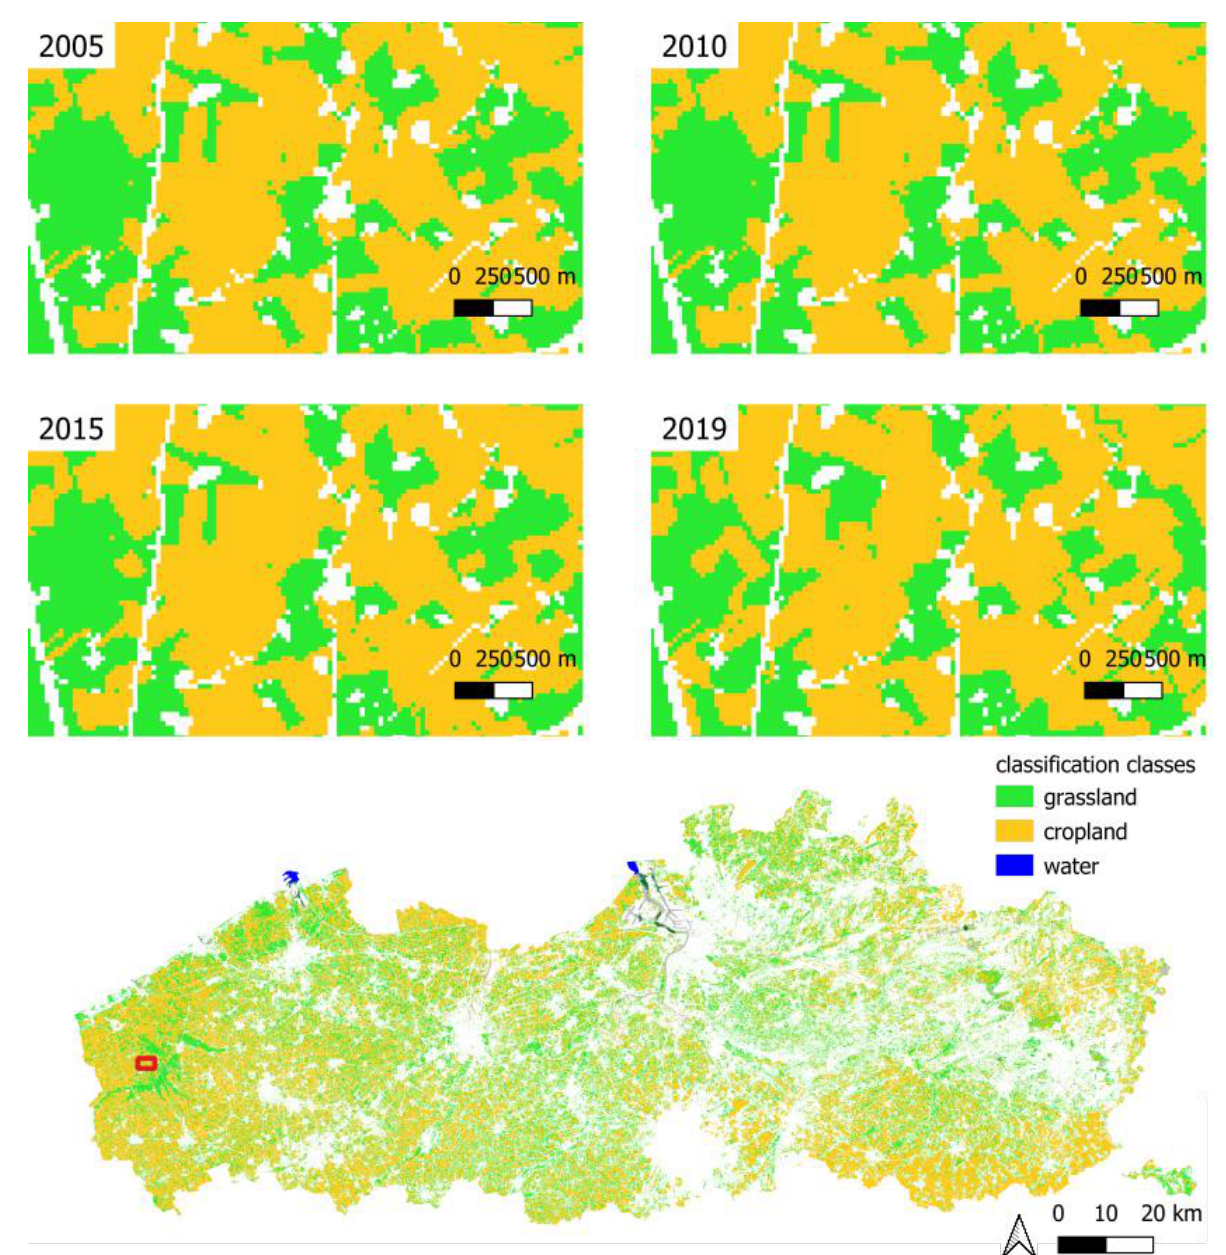
Figure 2. Snapshot of the historical land cover classification maps for the years 2005, 2010, 2015 and 2019 and overview of the classification product (2019). The red square on the map of Flanders indicates the snapshot area.